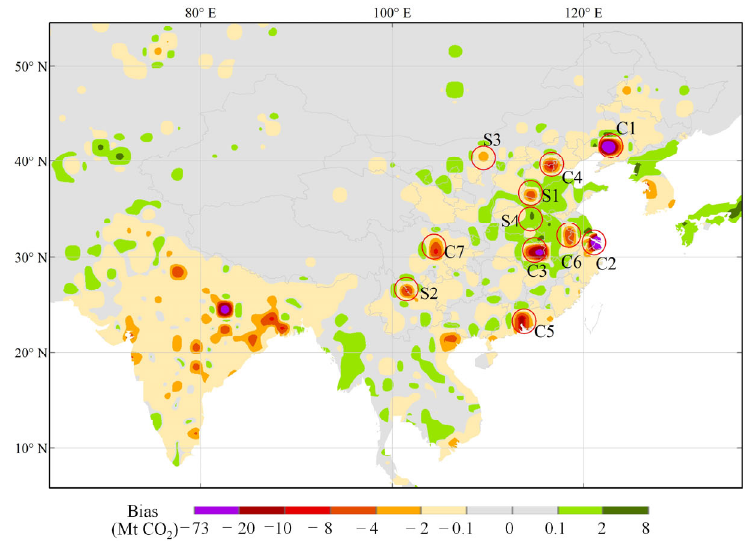
Figure 7. Locations of ROIs in China overlapped with the prediction biases for EDGAR in 2019 where the red circles tagged by C1–C7 are around the cities, and S1–S4 are around towns and villages.